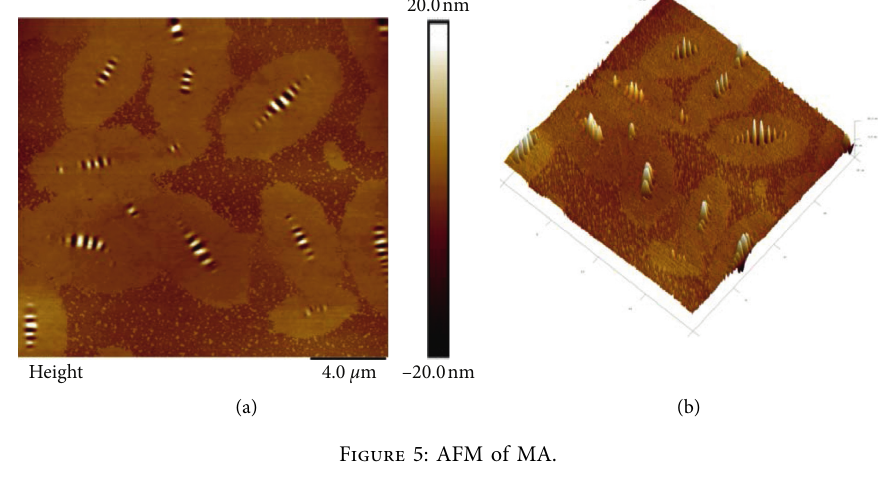
Figure 5: AFM of MA.